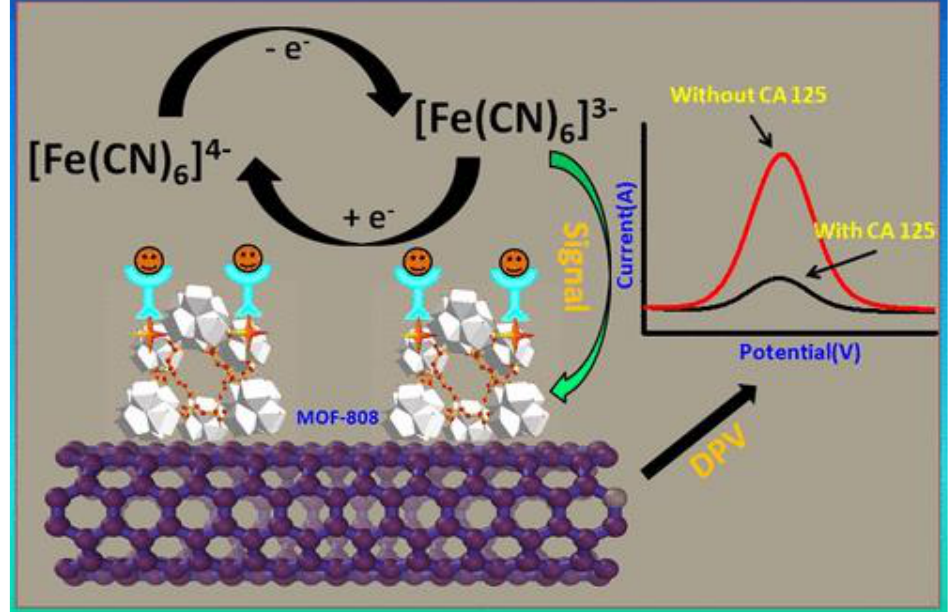
Figure 2. Illustration of the label-free electrochemical immunosensor fabrication. A glassy carbon electrode modified with MOF-808/CNT composite was used as a platform. The antibody binding sites of MOF-808/CNT were enriched by functionalization with streptavidin. Adapted with approval from [84]. Copyright 2015 American Chemical Society.